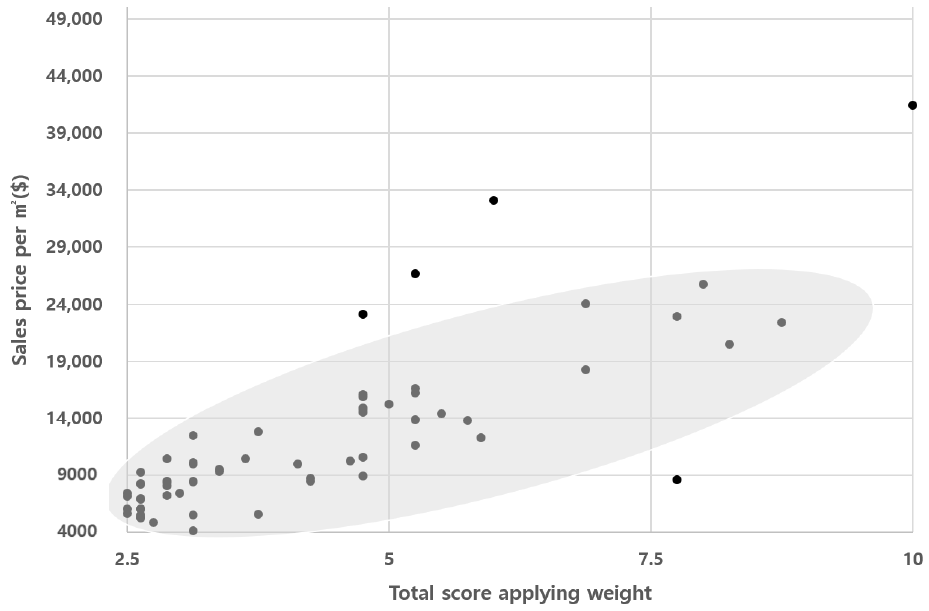
Figure 7. Scatter plot of total score correlated factors and sales prices per m 2 applying weight.